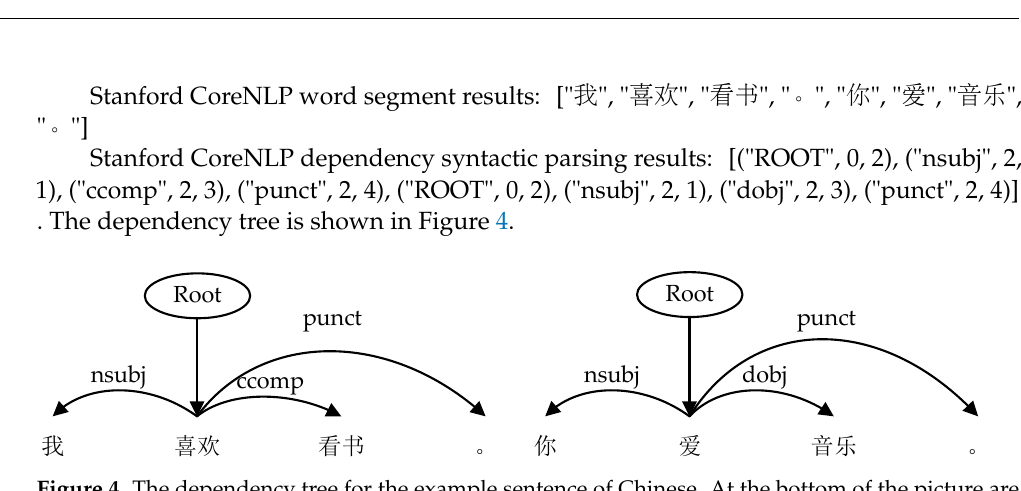
Figure 4. The dependency tree for the example sentence of Chinese. At the bottom of the picture are the word segmentations of the example sentence, the abbreviation above the arrow represents the dependent relation between two words.